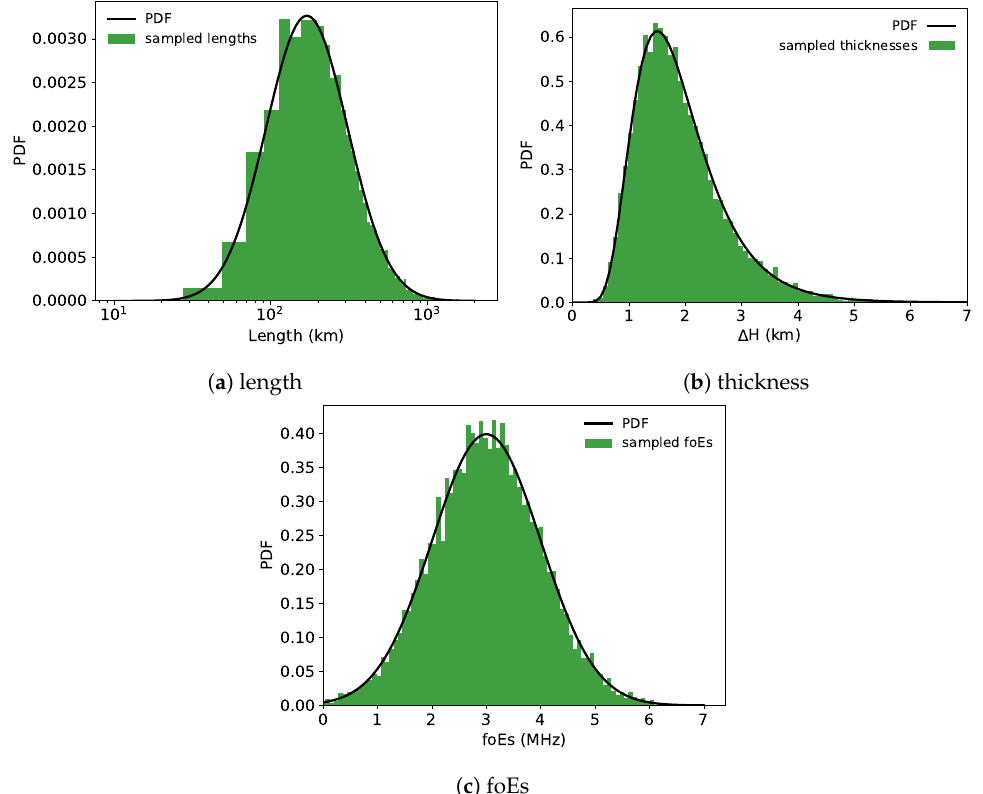
Figure 5. Probability distribution functions (PDFs) of the E s lengths from the lognormal distribution outlined in [39], the vertical thicknesses from the lognormal distribution outlined in [20], and the foEs magnitudes from the Gaussian distribution outlined in [22], along with histograms of the 10,000 random samples used in the